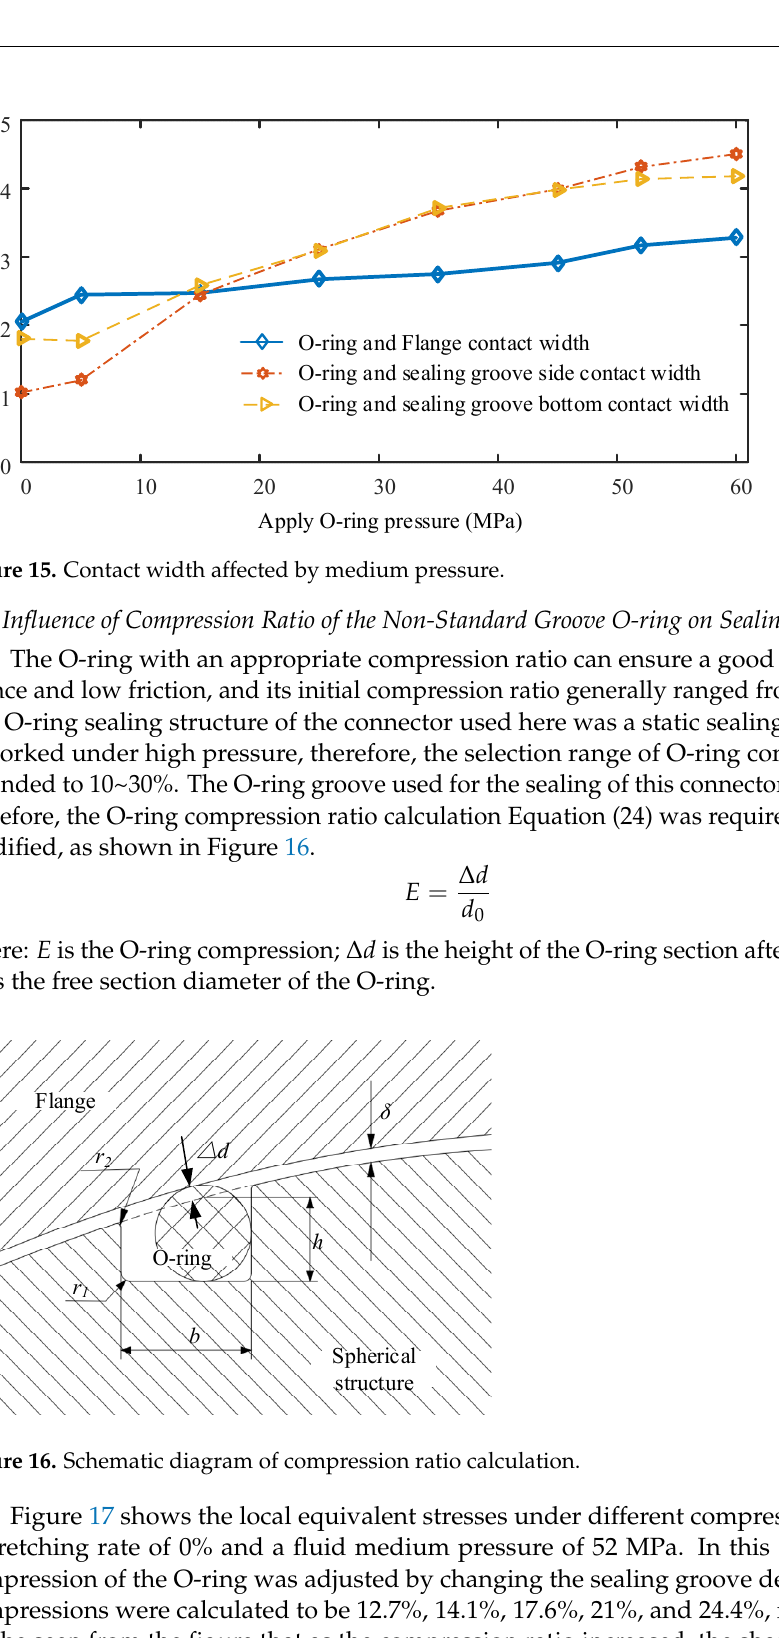
Compression ratio ： 24.4% Figure 17. Diagrams of equivalent stresses under different compression ratios. From the calculation results in Table 4, it was concluded that, under different com- pression ratios, the maximum contact pressure of the O-ring was greater than the fluid medium pressure of 52 MPa, which therefore meets the sealing conditions. Meanwhile, as shown in Figures 18 and 19, as the compression ratio increased, the corresponding maxi- mum contact pressure and maximum equivalent force both increased, and the increase in the maximum contact stress was greater than the maximum equivalent force.